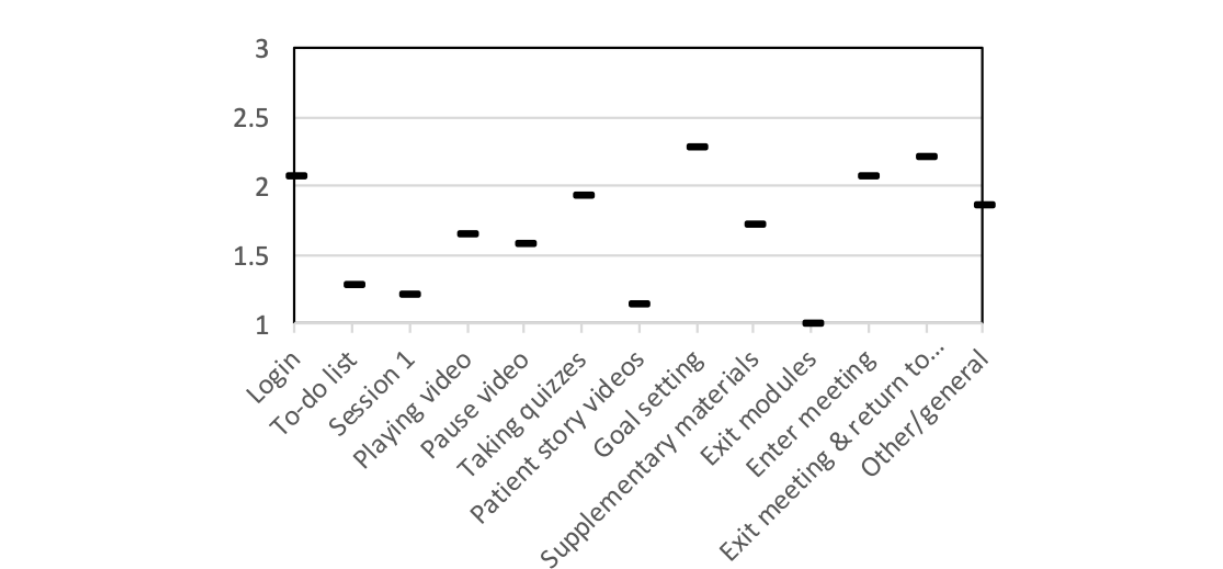
Figure 4. Difficulty of use scores (scale of 1 to 3) for each intervention application feature. A score of 1 indicates the participant was able to accomplish the task on their own with little difficulty. A score of 2 indicates some difficulty and a score of 3 indicates considerable difficulty requiring assistance to complete the task. The y-axis represents the difficulty score, and the x-axis shows the task performed by the patients.